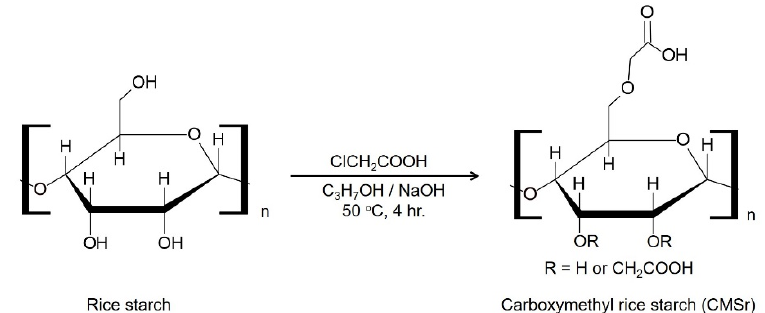
Scheme 1. Synthesis of carboxymethyl starch (CMS) from rice